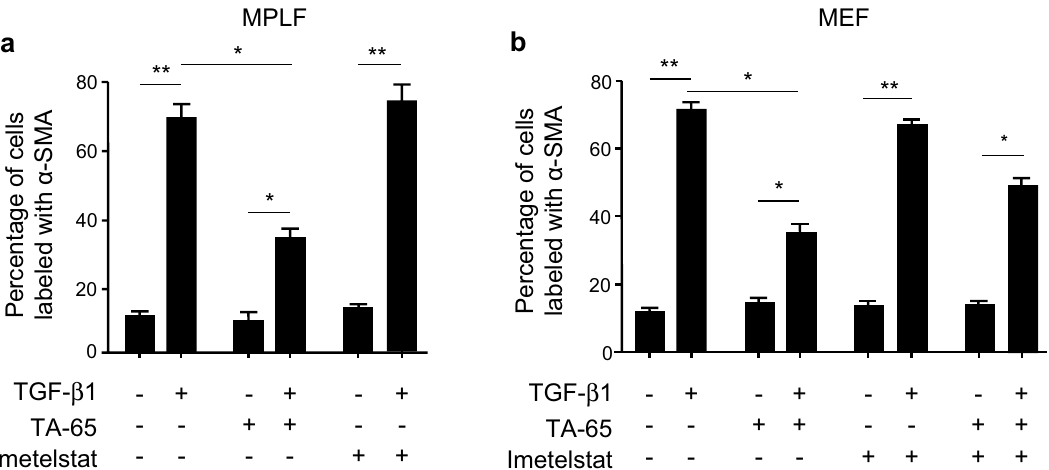
Figure 4. Effects of TA-65 on TGF-β-induced fibroblasts-to-myofibobroblasts differentiation in vitro. Mouse primary lung fibroblasts (MPLF) and MEF cells were pre-treated with TA-65 (2 µM) or Imetelstat (1 µM) during 24 h, followed by TGF-β treatment (10 ng/mL) for 48 h. Histograms show quantification of α-SMA expression evaluated by immunostaining ( a : MPLF; b : MEF). Representative images of cells stained with α-SMA monoclonal antibody are available in Supplementary Fig. S3. n = 3 samples per group. Data are presented as mean ± SEM. *p < 0.05, **p < 0.01.